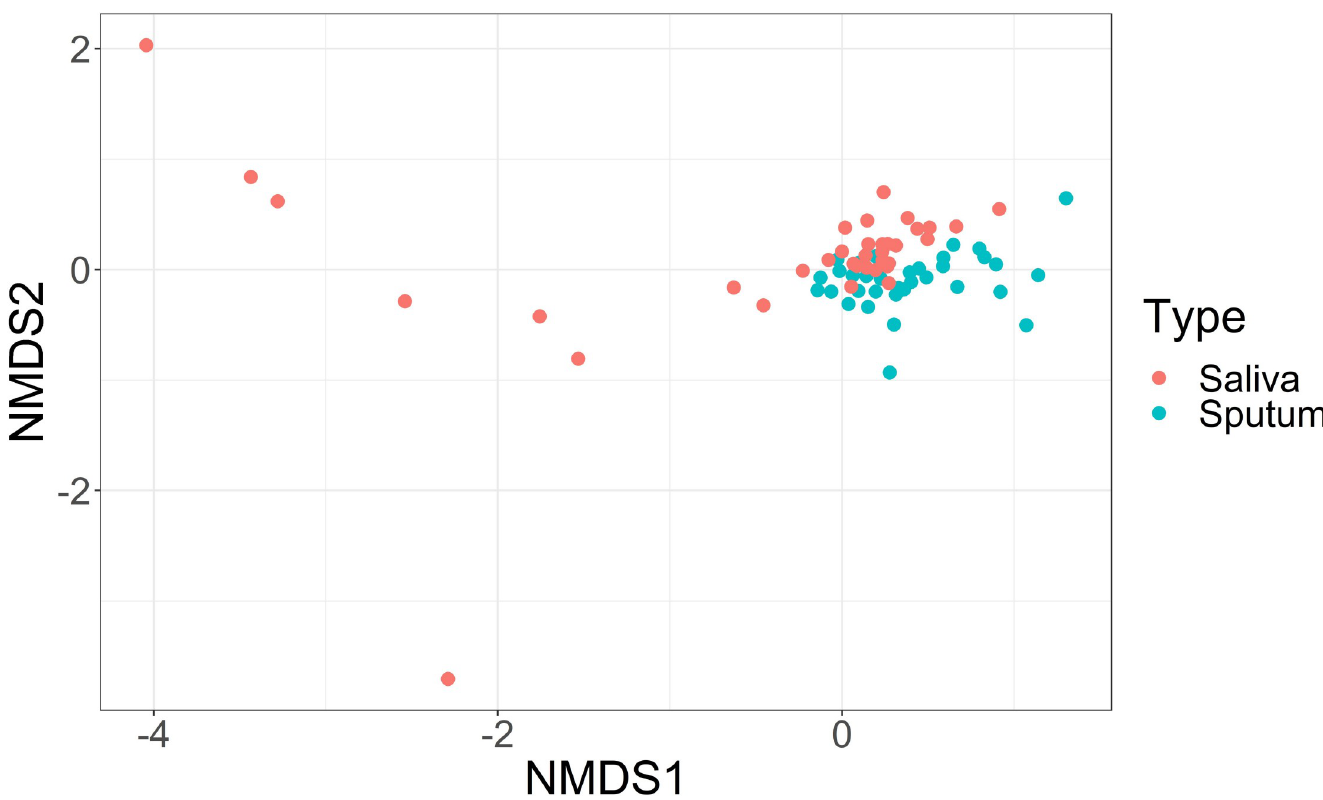
Fig 2. Non-metric multidimensional scaling (NMDS) of Bray-Curtis distances of bacteria in saliva and sputum samples.